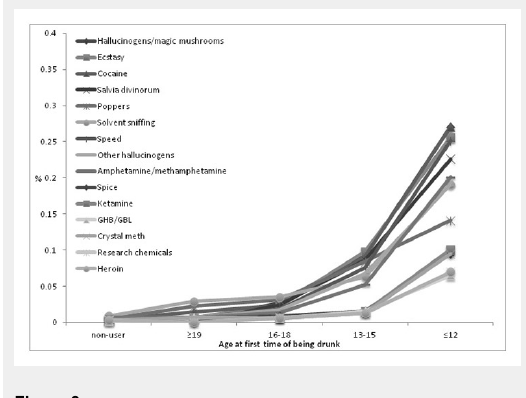
Prevalence rates for drug use according to age at first drunkenness.The prevalence rate for each drug is given according to the age of onset of being drunk. For example, 7.0% of the participants who first got drunk at age 12 years or earlier used heroin, whereas only 1.3% of the participants who first got drunk at age 13 to 15 used heroin (percentages can be found in table 6).